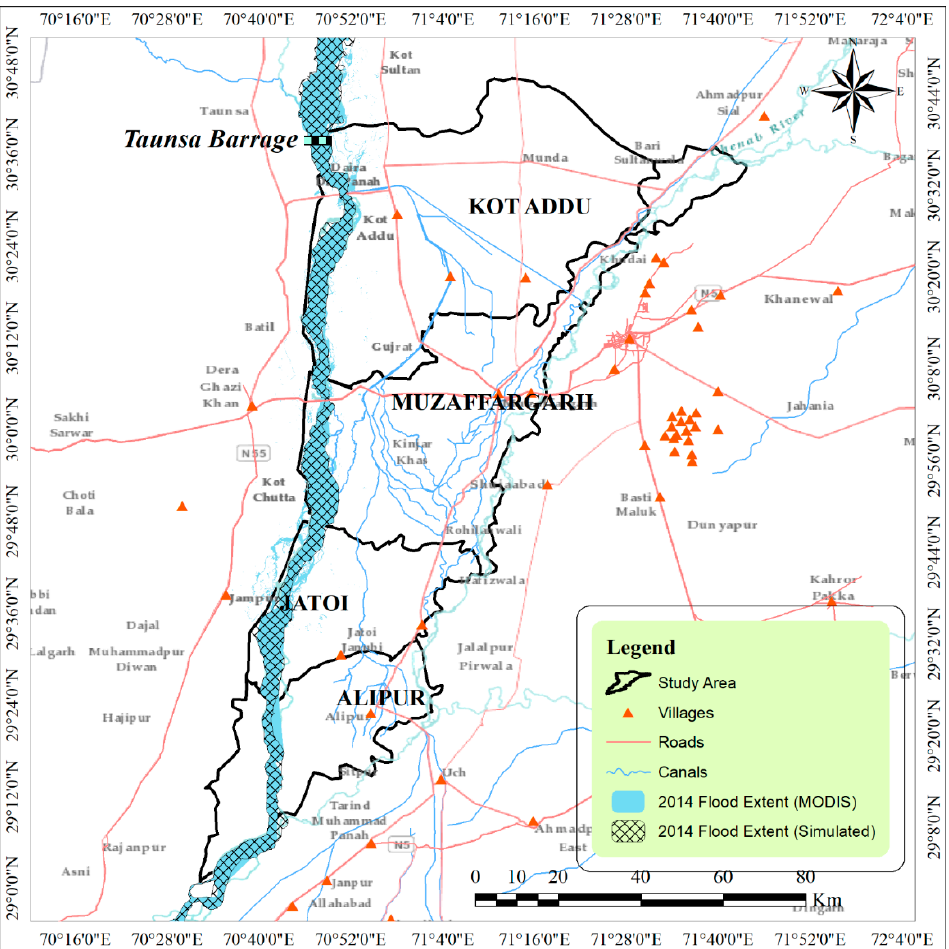
Figure 9. Comparison of the extent of the 2014 flood according to the MODIS satellite image and the hydraulic simulation of the flood. Table 6. Percentage of the surface area flooded during floods of different return periods.